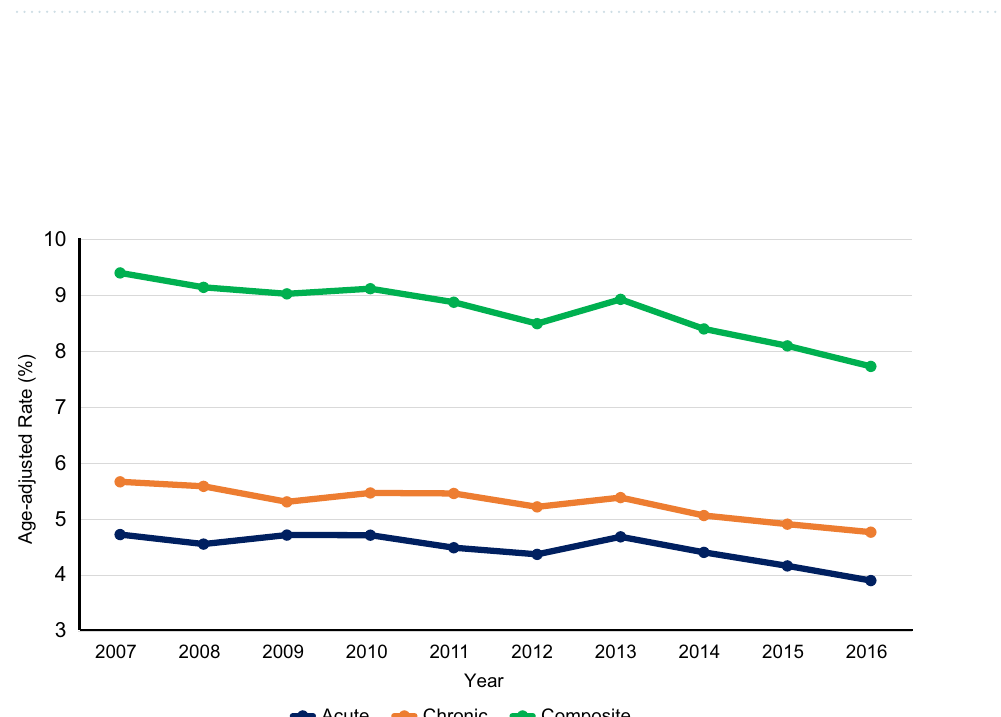
Figure 2. Trends of acute, chronic, and composite prevention quality indicator (PQI) hospitalizations in the United States,